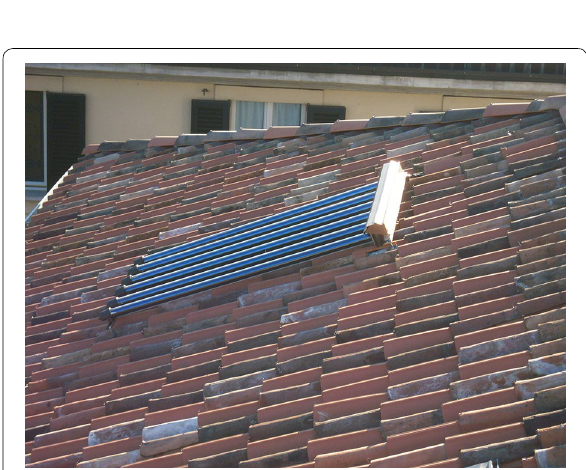
Fig. 25 Solar thermic panel on the roofing: regulatory requirement for the production of hot water (picture by